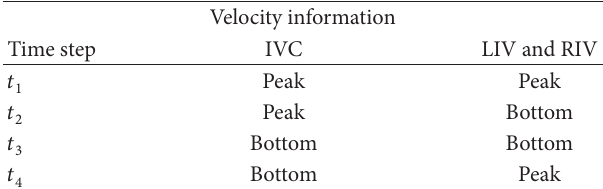
Table 1: The definition of four selected time steps at Figure